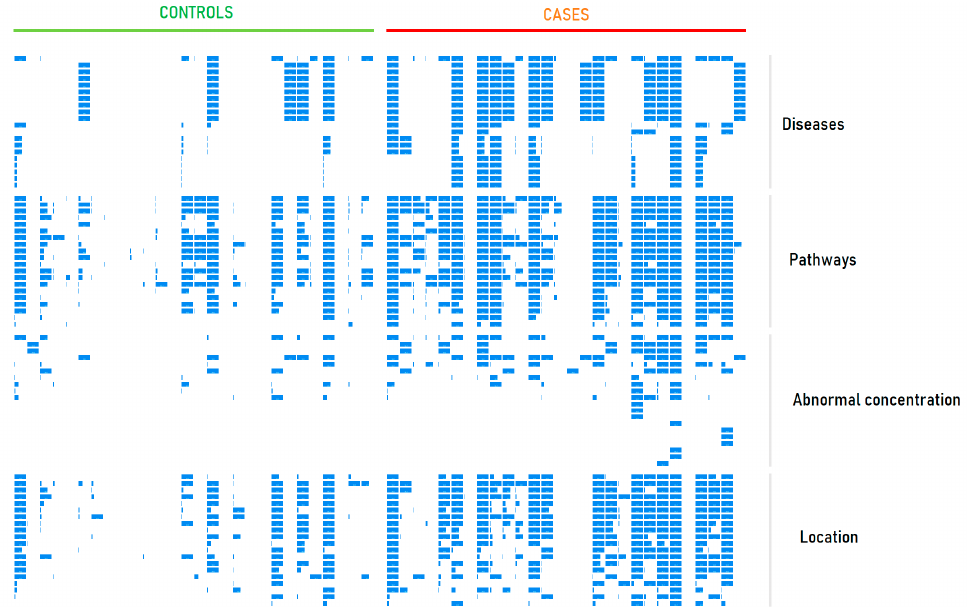
Figure 3. Metabolite set representation scores produced by the laboratory-developed test (LDT) for control subjects and patients with Parkinson’s disease (PD). The rows correspond to the metabolite sets presented in Table 2. The widest bands correspond to a metabolite set representation score of 75.